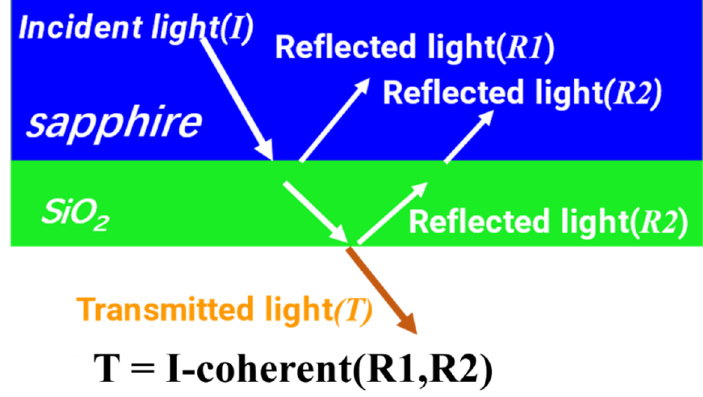
Figure 3. Optical simulation of SiO 2 /Al 2 O 3 structure.